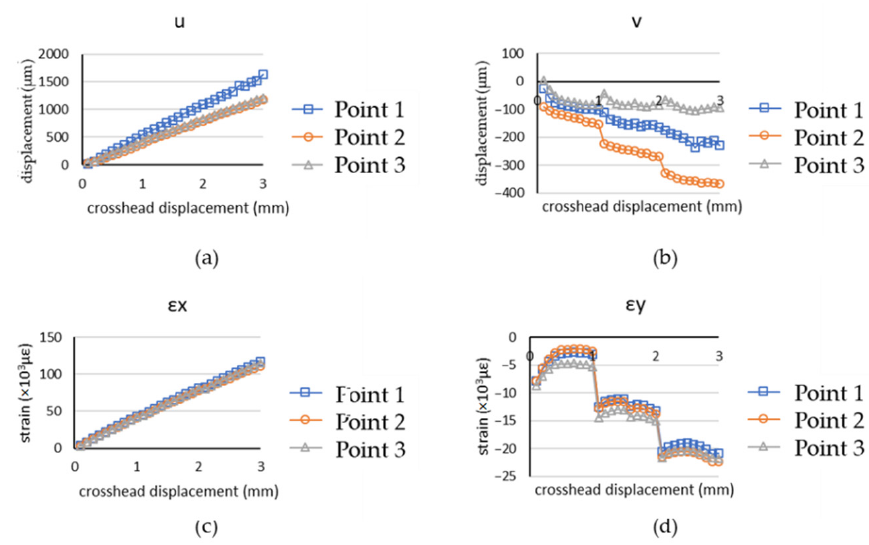
Figure 14. Results of biological tissue tensile testing ( a ) axial displacement, ( b ) transverse displace- ment, ( c ) axial strain, ( d ) transverse strain.